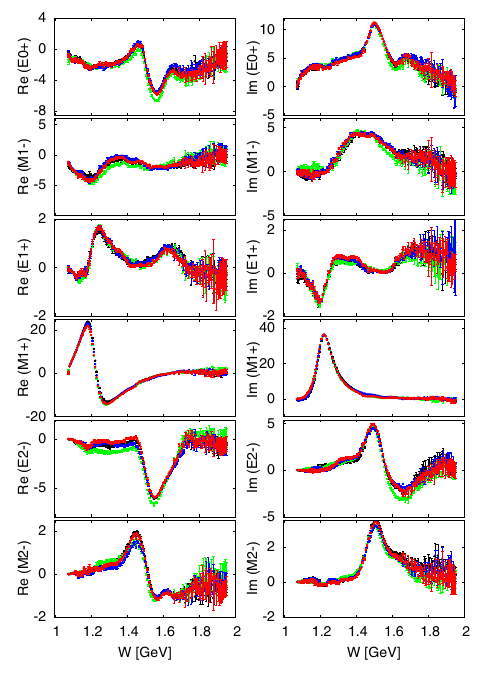
Figure 8: (Color online) SE solutions for the few lowest partial waves obtained using di ff erent models as initial so- lutions (BnGa (black),JuBo (blue), SAID (red) and MAID (green)). Multipoles are in units of mfm. Figure is taken over from ref.